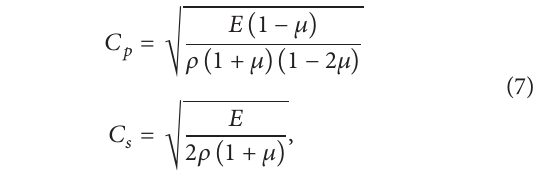
Figure 4: Simplified topographic map of the Zhaoshuling Landslide area.